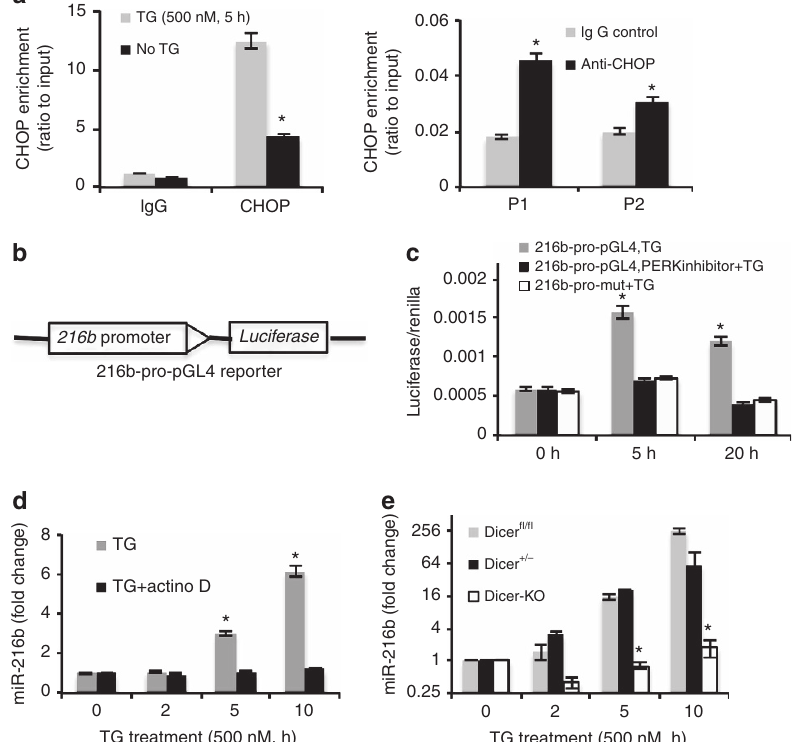
Figure 3 | CHOP binds to miR-216b promoter region. ( a ) Occupancy of CHOP on the promoter of mouse miR-216b. NIH3T3 cells (left panel) and U2OS (right panel) were treated with/without TG for 5h, followed by ChIP assay using IgG or an anti-CHOP antibody. Precipitated DNA was subjected to qPCR analysis. All ChIP data represent the mean and standard error of the mean from three independent experiments. ( b ) Schematic representation of miR-216b promoter reporter (216b-pro-pGL4; left panel). ( c ) 293T cells were co-transfected with 216b-pro-pGL4, 216b-mut-pGL4 and Renilla-Luc as an internal control. 48h post transfection, cells were treated with PERK inhibitor followed by TG treatment for intervals as indicated. Values are the ratios of firefly to Renilla luminescence (mean ± s.d. of triplicate experiments). ( d ) NIH3T3 cells were treated with/without actinomycin D (2 m gml (cid:2) 1 ) for 1h and challenged with 500nM TG as indicated. MiR-216b levels were measured with qPCR (mean ± s.d., n ¼ 3). ( e ) Dicer flox/flox , Dicer þ / (cid:2) and Dicer (cid:2) / (cid:2) MEFs were treated with 500nM TG, qPCR assessment of miR-216b (left) and chop mRNA (right). Data represent mean ± s.d. of three independent experiments and statistical analysis was analysed by Student’s t -test (* P o